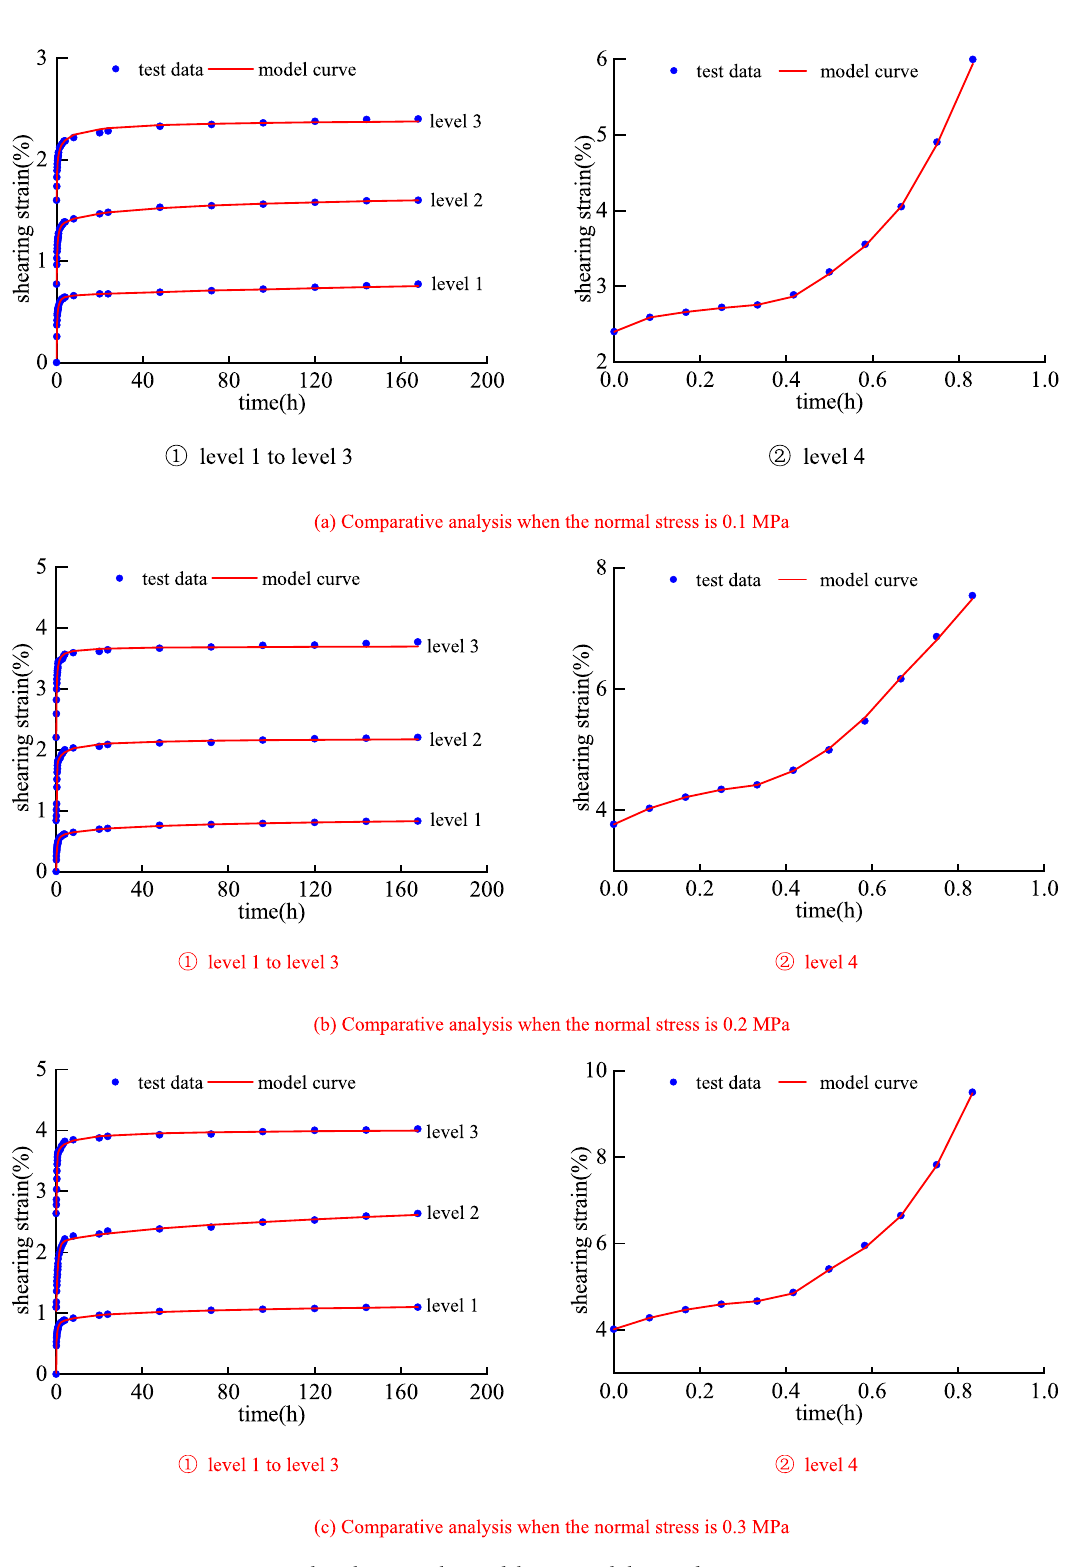
and Fig. 10c,d shows the effect of different values of parameters d and e on the varying-parameter viscoelastic body. Based on the test data of 0.1 MPa normal stress and 0.0576 MPa shear stress, Fig. 10e,f shows the influence of different values of parameters b and c on the creep curve of the damaged viscoplastic body.